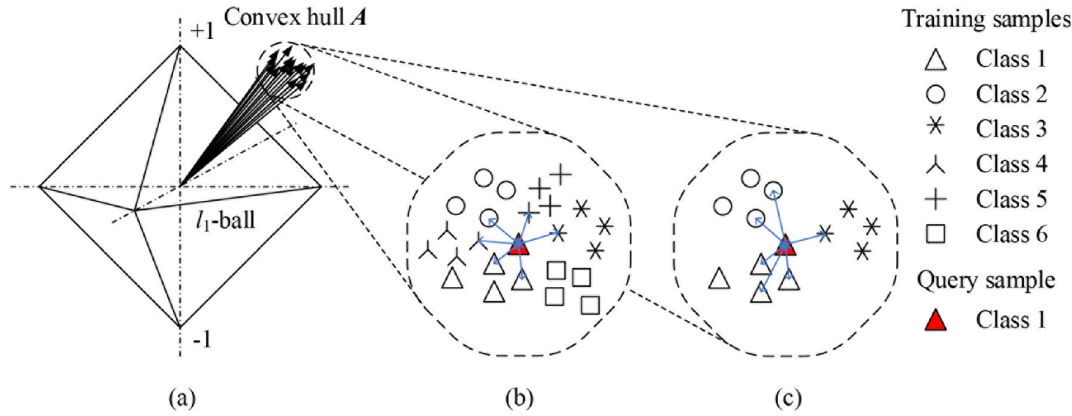
Fig. 7 a Convex hull spanned by all dictionary atoms on the unit sphere; b , c Two toy examples illustrating K (cid:2) 6 sparse L 0 -norm optimization results on different scale dictionaries sphere S M − 1 , and the training vectors are tightly